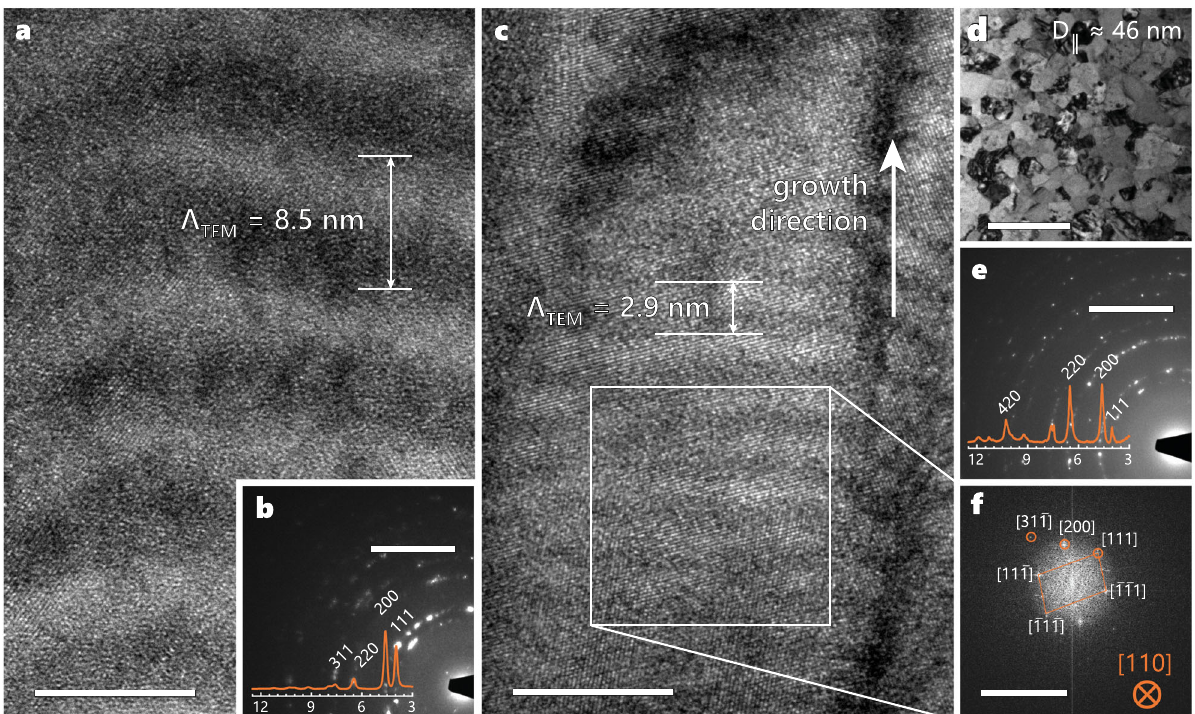
Fig. 3 TEM studies describing the microstructure. The HR-TEM micrographs ( a ) and ( c ) show a cross section of coatings with a nominal bilayer period of 9.0 and 3.0 nm, respectively. The white marked area in ( c ) was used to generate the FFT pattern in ( f ) calculated by Gatan Digital Micrograph. The TEM top view in ( d ) was taken from the sample with Λ = 1.5 nm, the column width was calculated using the linear intercept method. ( b ) and ( e ) show a SAED pattern of the region in ( a ) and ( d ), respectively, including an integration of the pattern. The scale bars in ( a ) and ( c ) are 10 nm, in ( b ) and ( e ) 5 nm − 1 , in ( d ) 200 nm, and in ( f ) 10 nm − 1